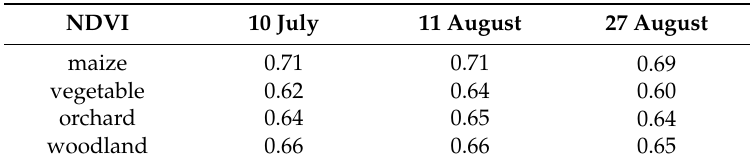
Table 4. NDVIs of maize, vegetables, orchards and woodlands on 10 July, 11 August and 27